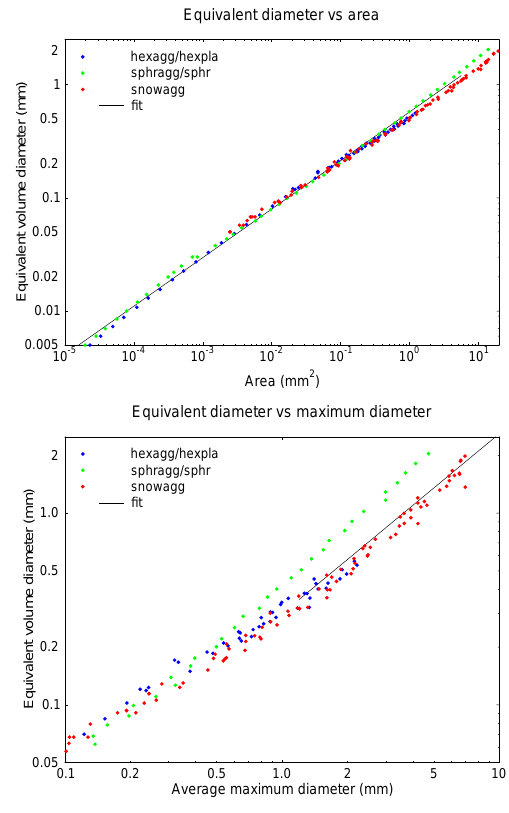
Fig. A1. The equivalent volume sphere diameter as a function of av- erage projected area and average maximum diameter for randomly oriented particles used in the retrieval algorithm scattering tables. The power-law fits used for the 2D-S probe (top panel) and PIP (bottom panel) are also